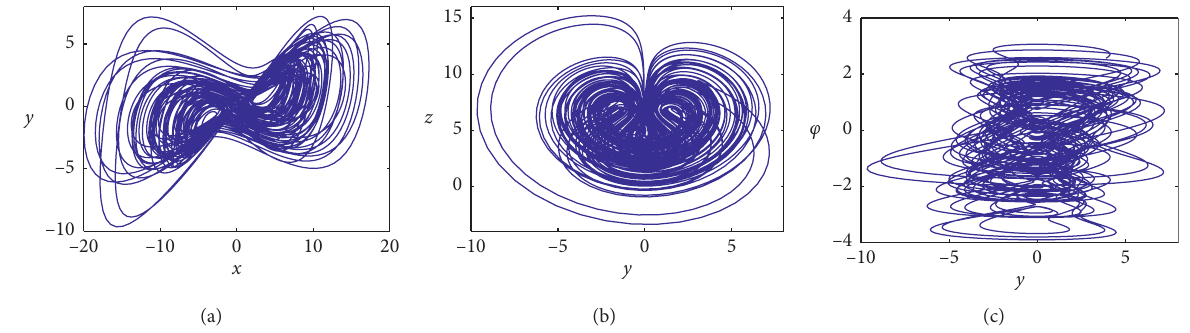
Figure 13: Phase portraits of system (4) with memristor W ( φ ) � − m + n | φ| , m � 2, n � 5, and a � 2, b � 3, c � 5, d � 0.75, and k � 1: (a) x - y plane, (b) y - z plane, and (c) y - φ